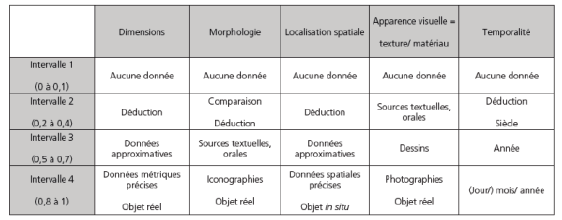
Table 1. Criterias used in our Intendance’s palace case study from Fabre-Brun (2015) article The Edition mode also represents in wireframe, as a quick visual indicator, those aspects with the lowest level of certainty (0 to